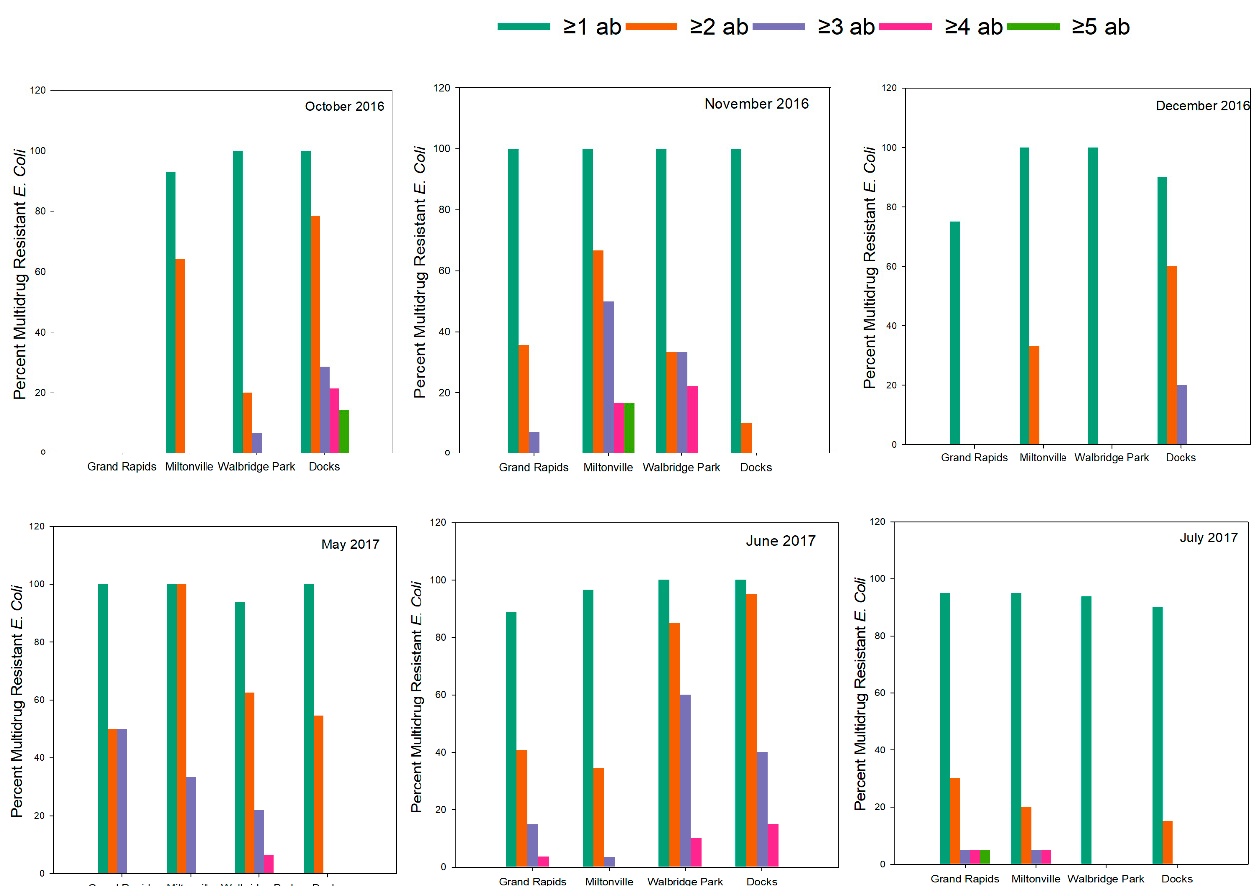
Figure 4. Percentage of multidrug resistance (MDR) within E. coli isolates in the four sites across all sampling events.